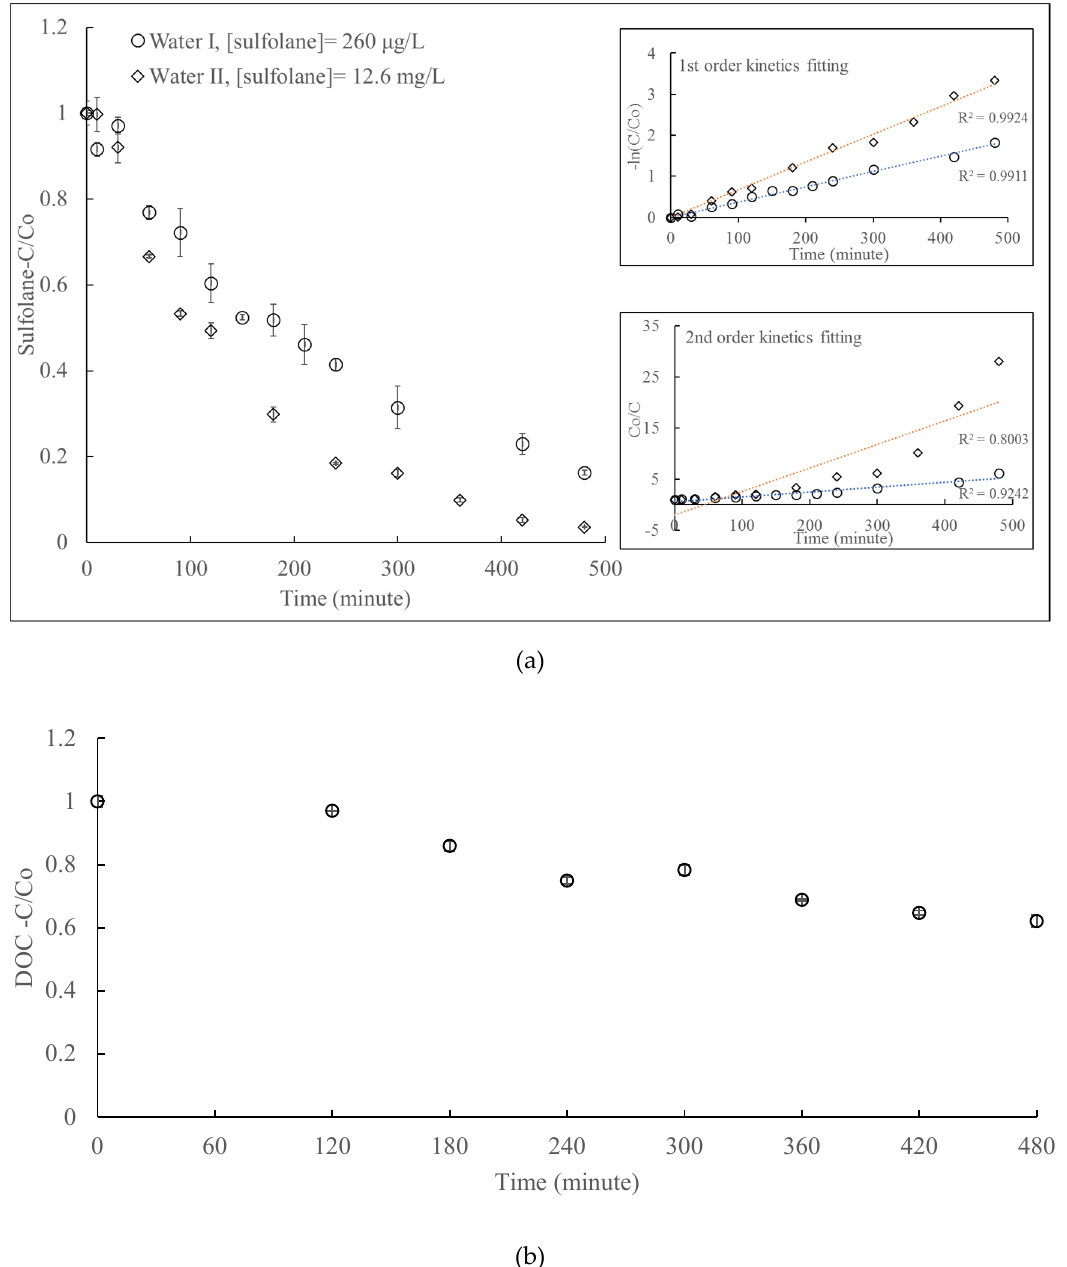
Figure 2. Degradation of sulfolane in the UV/H 2 O 2 pilot system—recirculation mode; [H 2 O 2 ] = 25–35 mg/L. ( a ) Sulfolane, ( b ) dissolved organic carbon (DOC) for Water II; initial DOC was 13.28 mg/L.